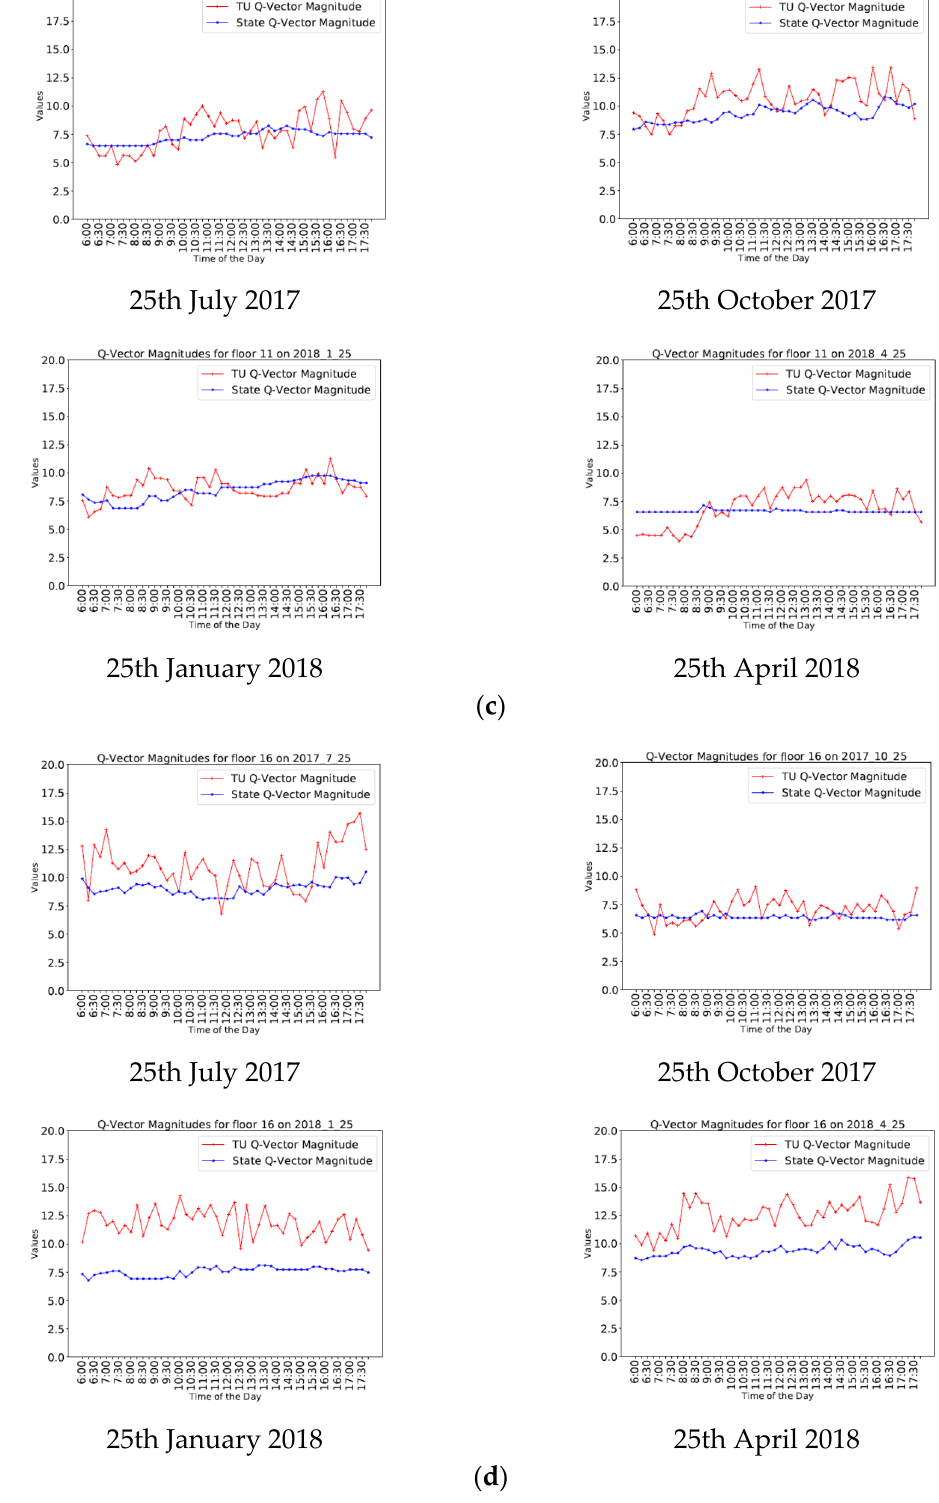
Figure 10. Graphs depicting the variation of TU Q-vector magnitudes and state Q-vector magnitudes on four different days across different seasons for ( a ) Floor 2 ( b ) Floor 6 ( c ) Floor 11 ( d ) Floor 16.